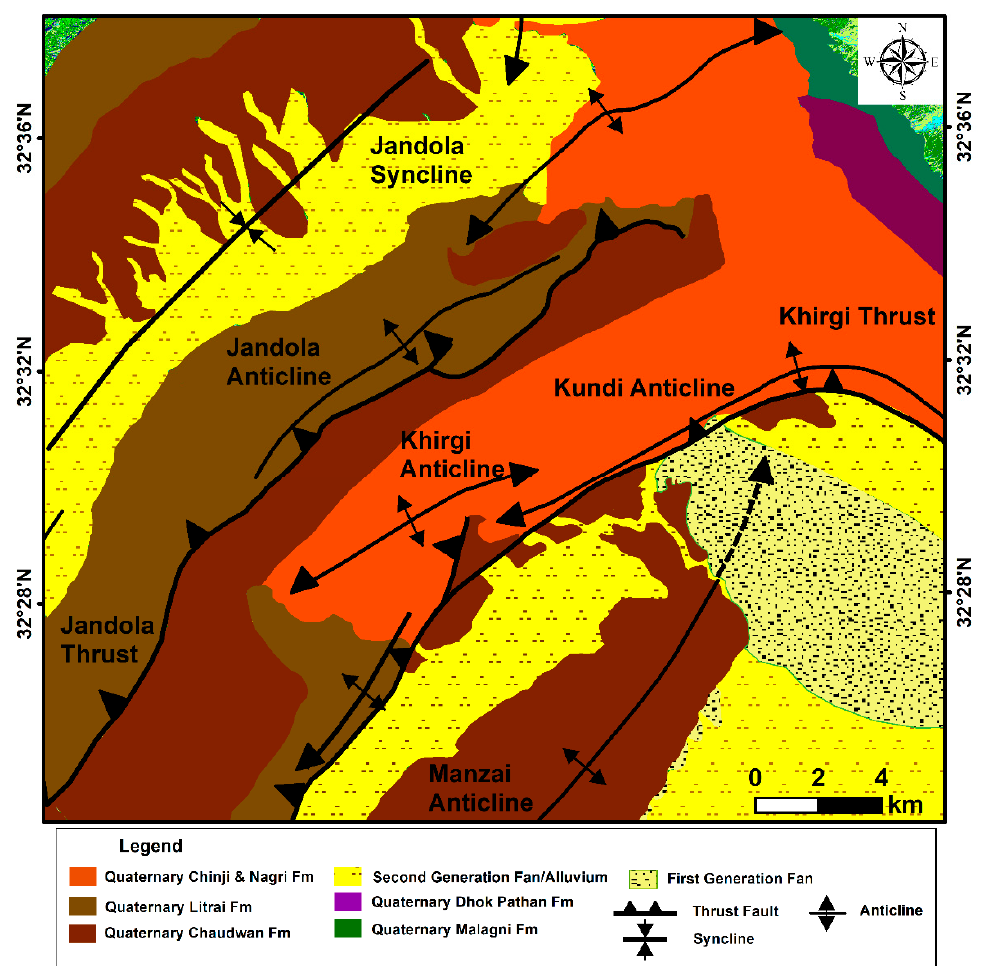
Figure 7. Geological map of the Manzai Ranges prepared using the Sentinel-2B dataset and older map. Quaternary sedimentary rocks outcrop all along the Manzai Ranges. The mapped thrusts are Khirgi and Jandola. The splay of the Khirgi Thrust and an unknown anticline are also mapped. Both faults are emplaced in older quaternary rocks over the younger in the foreland region. The active tectonic leads to the deformation of the alluvial fans, deflected and entrenched streams.